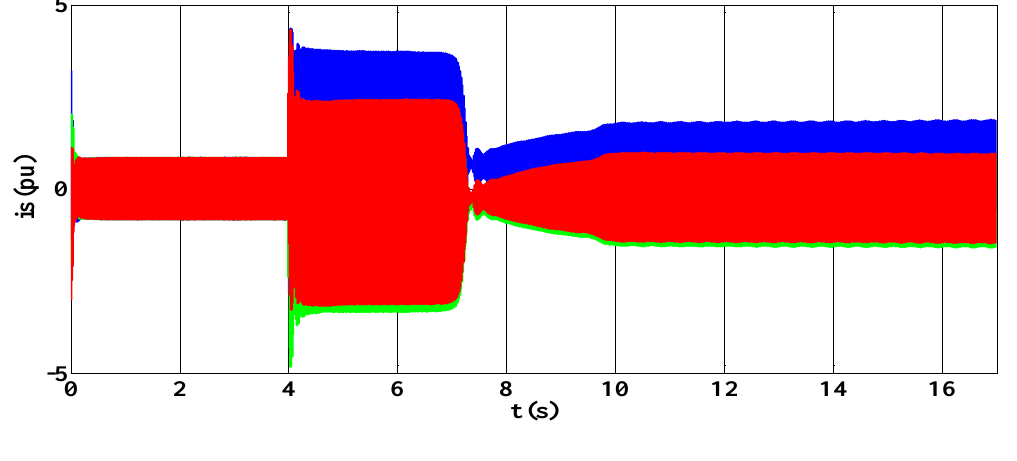
Figure 20. Stator currents (short-circuit happens at t = 4 s).